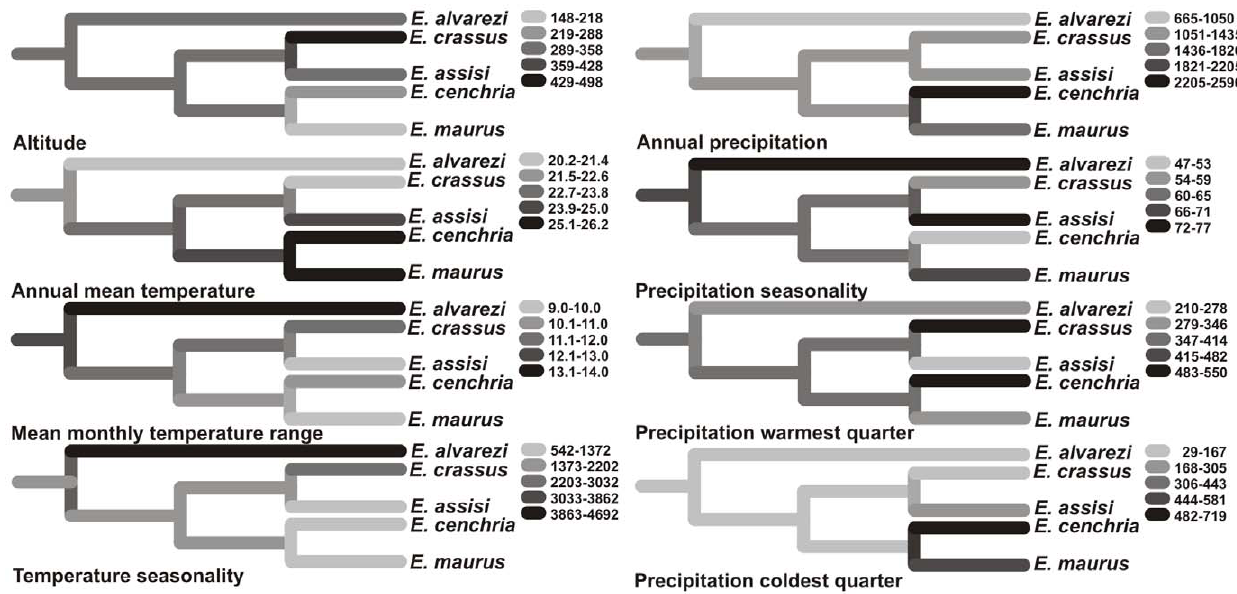
Figure 9. Estimated evolutionary patterns of altitude, annual mean temperature, mean monthly temperature range, temperature seasonality, annual precipitation, precipitation seasonality, and precipitation in the warmest and in the coldest quarter. Reconstruction of ancestral character states for ecological niche characters based on the phylogenetic tree derived from DNA sequences. Estimated ancestral trait values are shown at the internal nodes and visualized using a color gradient. The color gradient is described at the right of each tree.